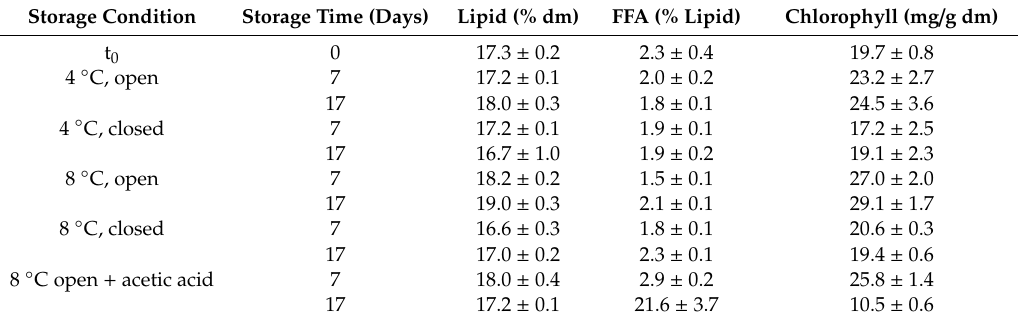
Table 1. Results of storage experiment 2. Concentrations are given as averages ± standard